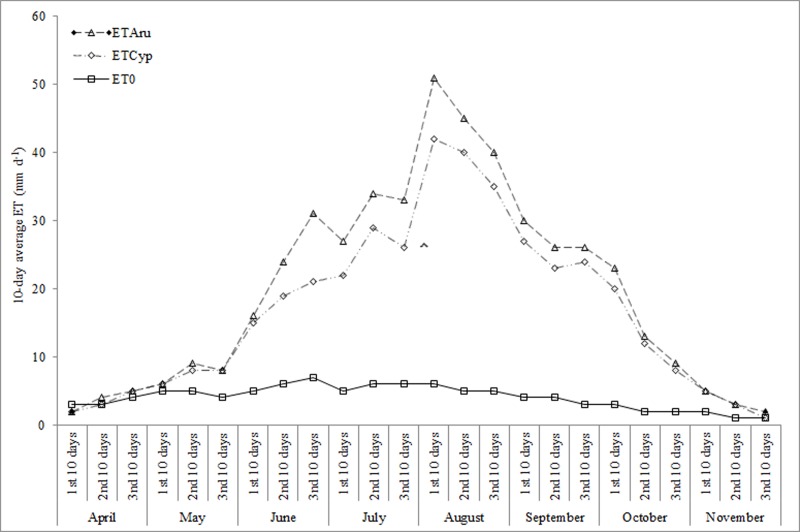
10 day-average ET0, ETaru and ETcyp in HSSFs CW(2) during the test period.